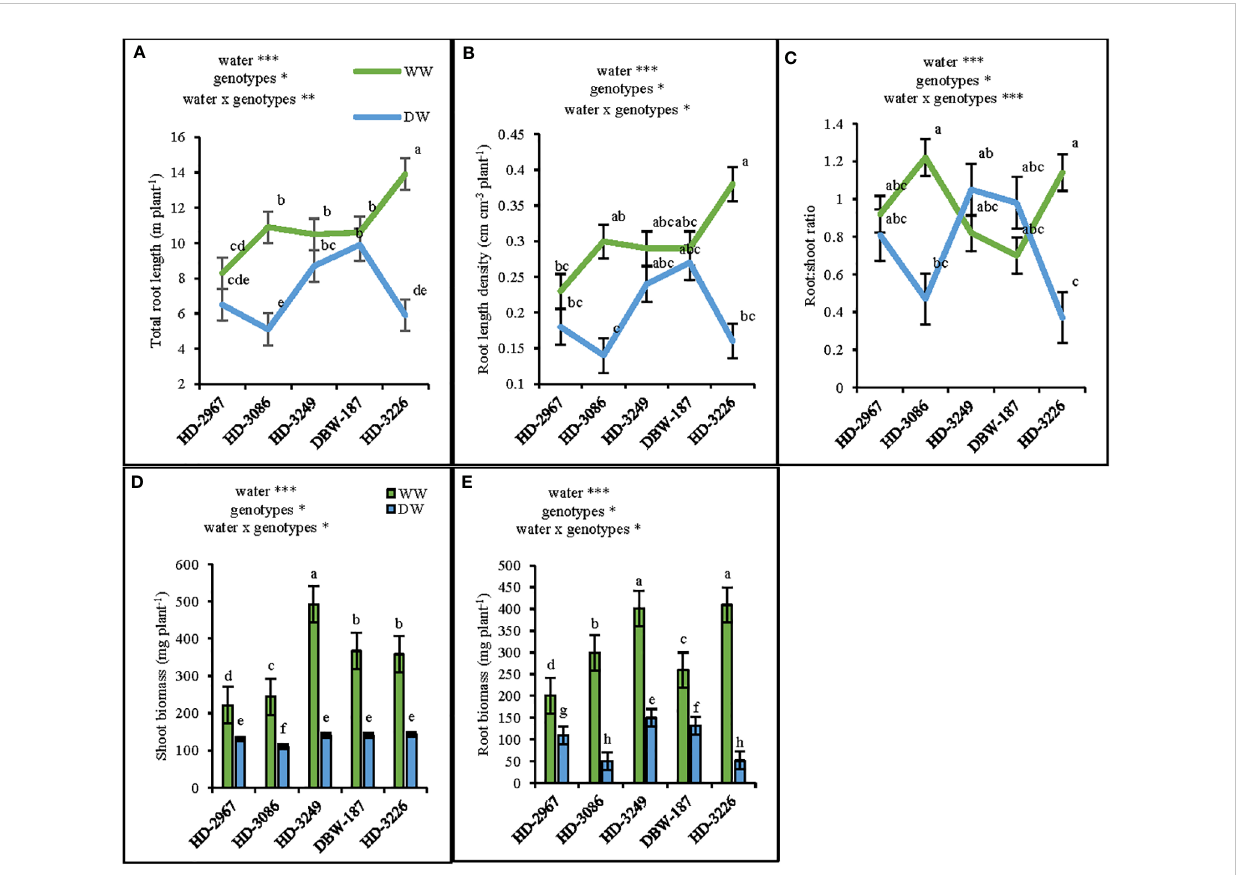
FIGURE 2 Root-system traits of the fi ve wheat genotypes at 45 days (Z25) under well-(WW) and de fi cit- (DW) watered conditions. (A) total root length, (B) root length density, (C) root: shoot ratio (D) shoot biomass, and (E) : root biomass. Letters above the lines and bars indicates signi fi cant difference among genotypes at p<0.02(Turkey ’ s HSD test). Signi fi cant at *0.05, **0.05, and ***0.001 probability